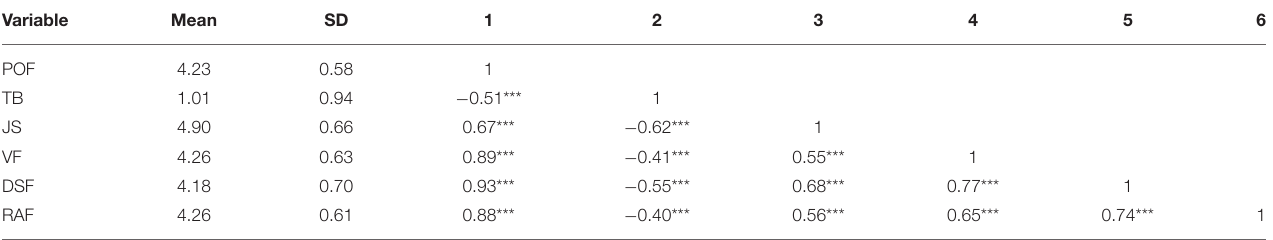
TABLE 2 | Means, standard deviations and correlations among variables. Variable